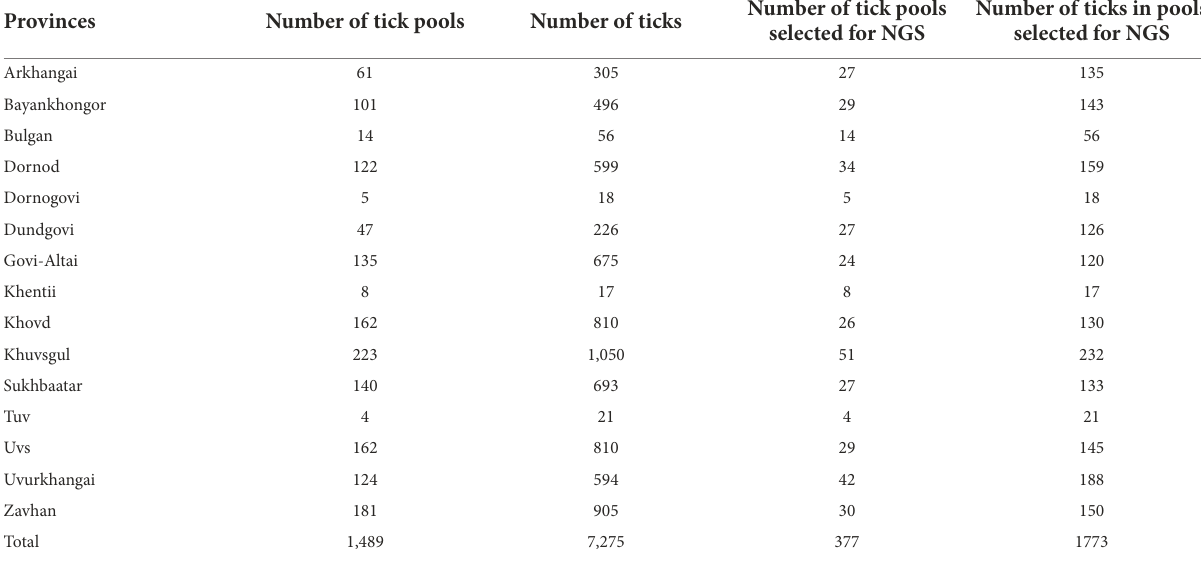
TABLE 1 Samples selected for pathogen screening by next-generation sequencing (NGS) in this study. Provinces Number of tick pools Number of ticks